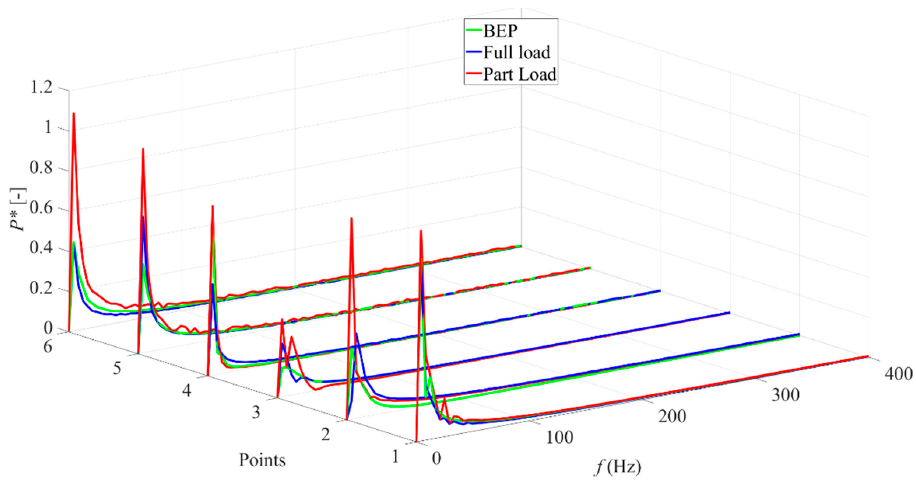
Figure 16. Frequency spectrum of pressure time signals inside draft tube.